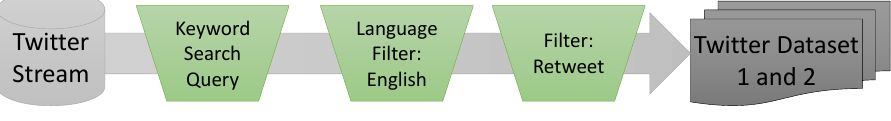
Figure 2. Twitter data collection pipeline.